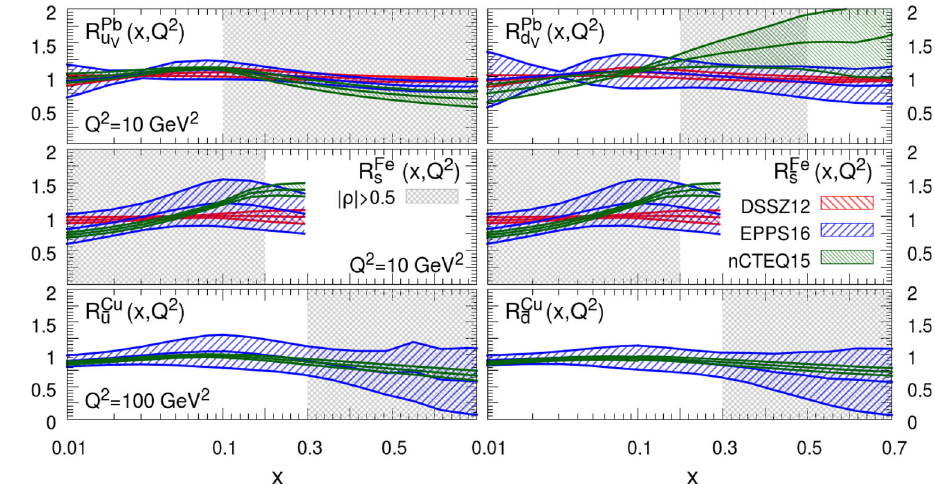
Fig. 3 The ratio R N between f the PDFs entering the nuclear and the proton observables, Eq. (9), for each of the nPDF sets considered in this analysis, and for the relevant flavours identified in Sect. 2.2. The shaded region corresponds to correlations | ρ | > 0 . 5 between PDFs and observables, see also Fig.